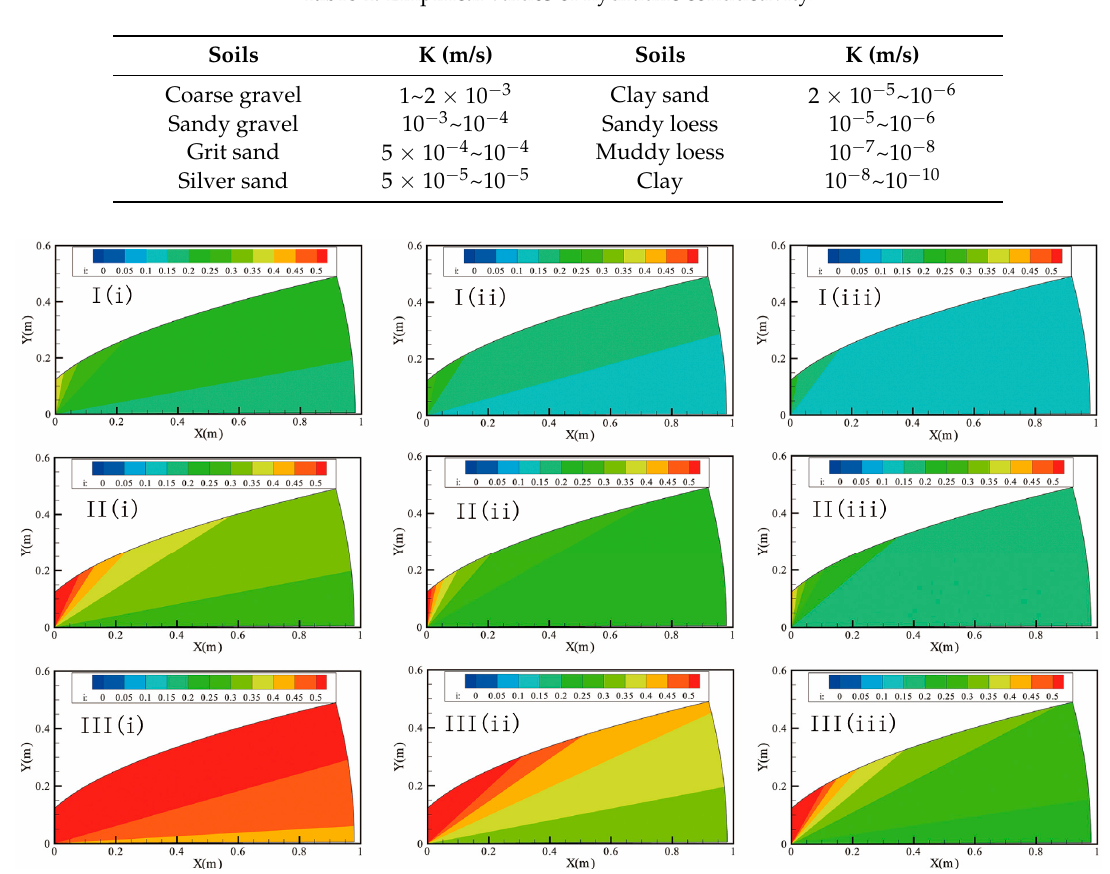
Figure 4. The distribution of the critical hydraulic gradients. In I, II, and III ∆ (cid:48) are 0.05, 0.1. and 0.2, respectively; in (i), (ii), and (iii) e are 0.3, 0.4, and 0.5,